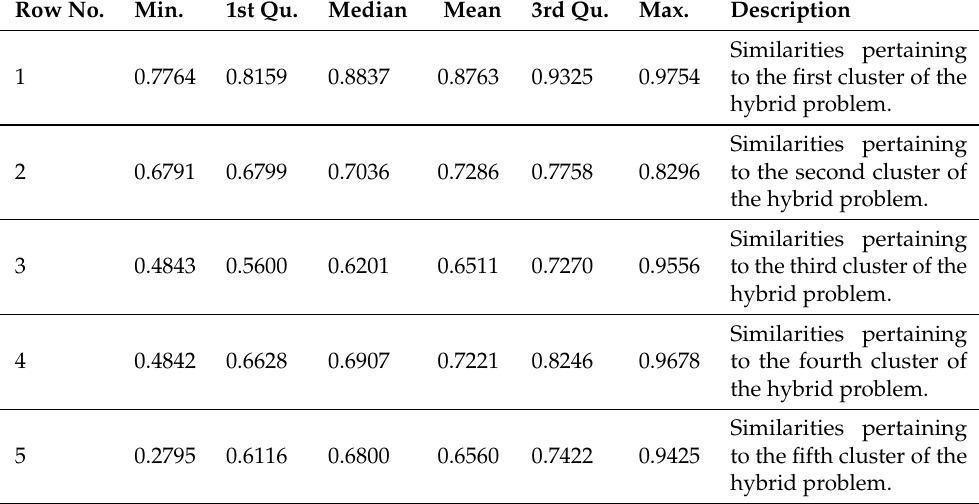
Table 6. The descriptive statistics of the similarity bonds within the clusters of the hybrid problem. Row No. Min. 1st Qu. Median Mean 3rd Qu.